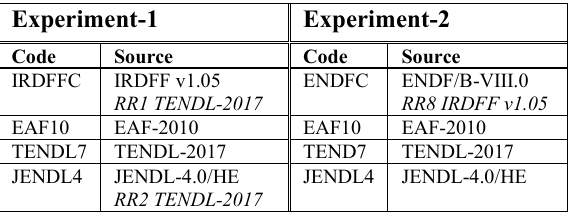
Table 2. List of response-functions for two experiments with the code-names and source-libraries. For response-functions with combined libraries, the reaction (RRx, ref. Table 1) and its source has been mentioned in italics, apart from the main source.